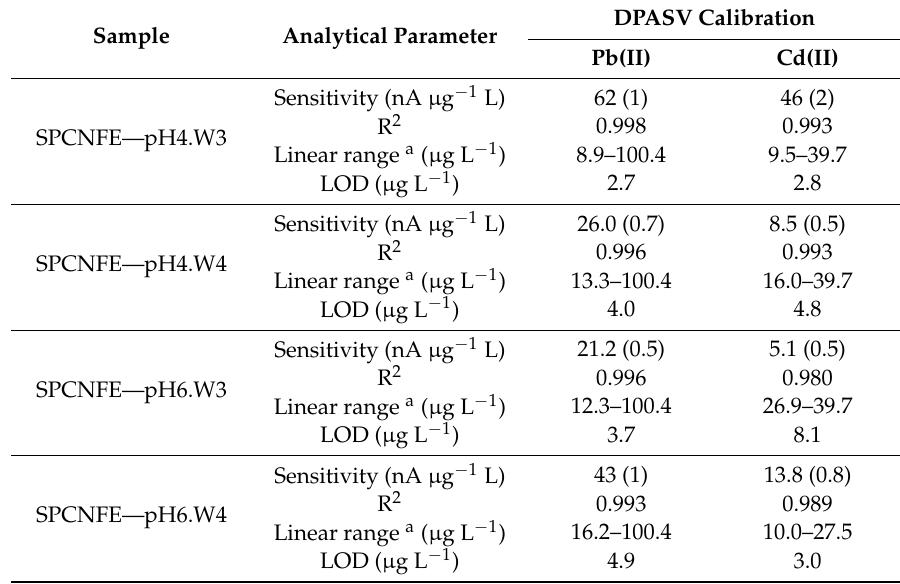
Table 2. Calibration data for the simultaneous determination of Pb(II) and Cd(II) at each Ag-NPs-SPCNFE at E d of − 1.4 V, t d of 120 s and pH 4.5. Standard deviations are denoted by